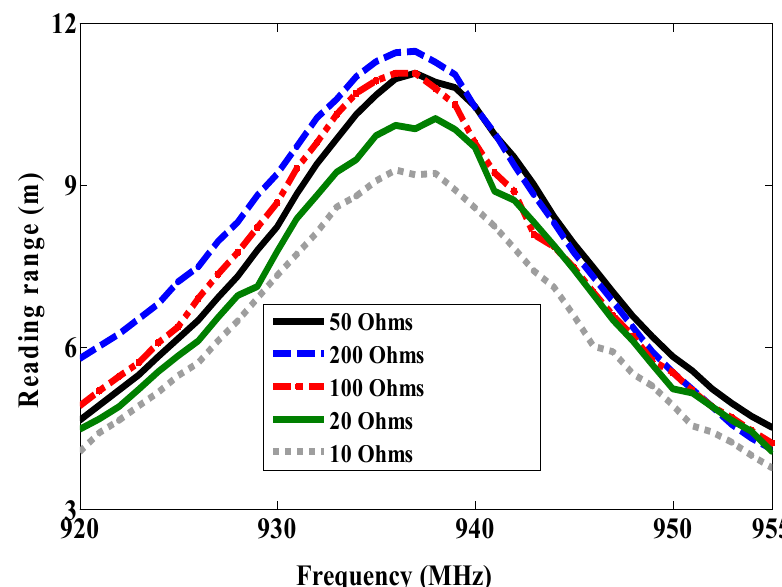
Figure 11. Measured reading range with different resistance (antenna B).